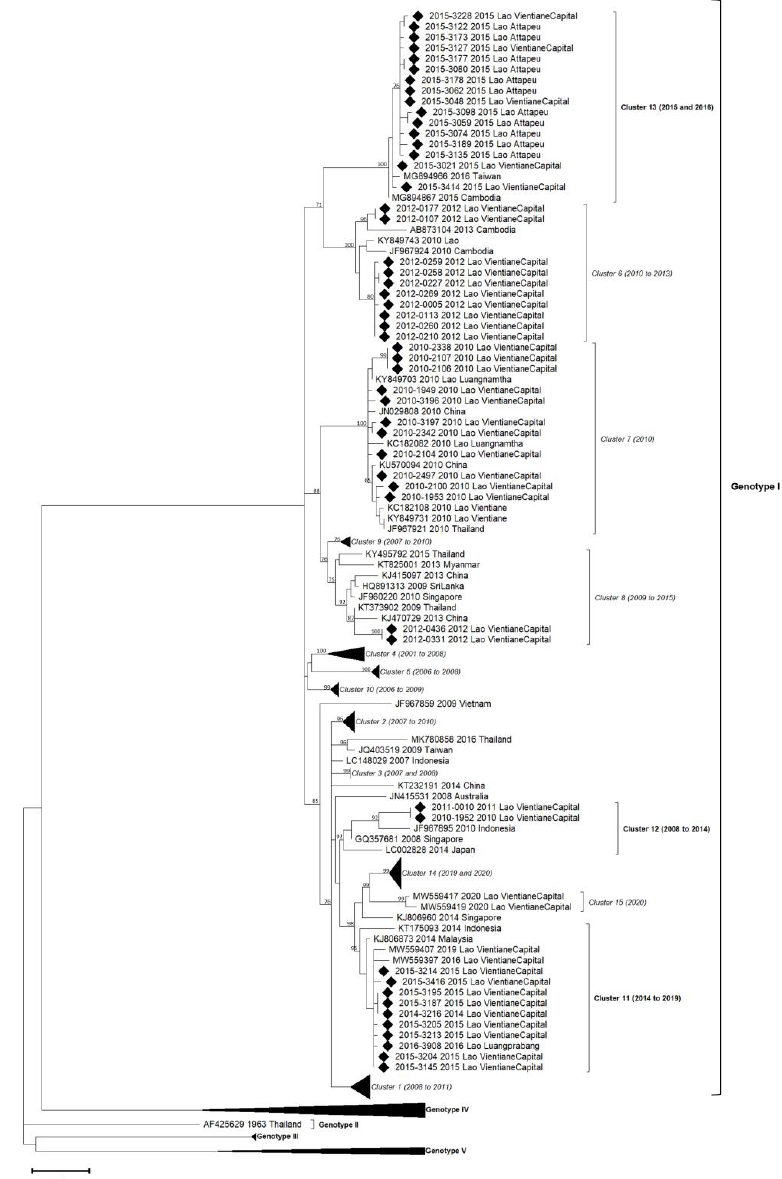
Figure 3. Phylogenetic analysis of DENV-1: 84 complete CDS protein E references of DENV-1 were selected from GenBank and aligned with the 51 DENV-1 sequences from this study (indicated with black diamond). Multiple sequence alignments were obtained using MAFFT version 7.023b. The unrooted phylogenetic trees were constructed using RAxML with general time-reversible plus gamma distribution substitution model and a rapid bootstrap (i.e., model GTR + I + G, bootstrap = 1000). The major genotypes and clusters in which sequences from this study are grouped are indicated. Statistical support values of grouping (maximum-likelihood bootstrap replicates >60%, as calculated by RAxML) are indicated at nodes of the tree. Scale bar indicates nucleotide substitution per site. Clusters in italics (C1 to C10) were predefined by Castonguay-Vanier et al., 2018, and Calvez et al., 2021, and reported in this phylogenetic tree. Clusters in bold were defined in this study (C11 to C13)